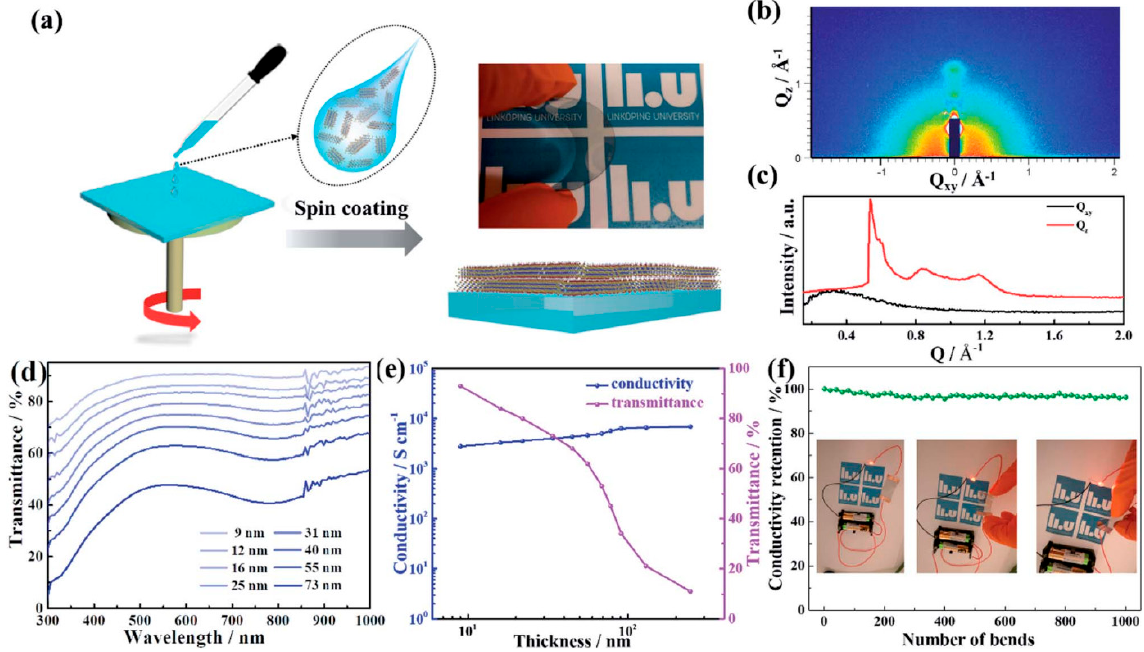
Figure 14. Optoelectronic properties of Ti 3 C 2 T x films. ( a ) Schematic of the preparation of a transparent flexible electrode. ( b ) Two-dimensional GIWAXS pattern of Ti 3 C 2 T x film prepared by the spin-coating method. ( c ) Out-of-plane and in-plane line-cut profiles from the GIWAXS pattern. ( d ) Transmittance spectra of Ti 3 C 2 T x films of various thicknesses. ( e ) Variations in conductivity and transmittance of Ti 3 C 2 T x electrodes as a function of thickness. ( f ) Conductivity retention with the number of bends for flexible Ti 3 C 2 T x electrodes on PET substrates. The inset image shows the conductivity of the Ti 3 C 2 T x electrodes in bent and twisted states, reprinted with permission from [136] .